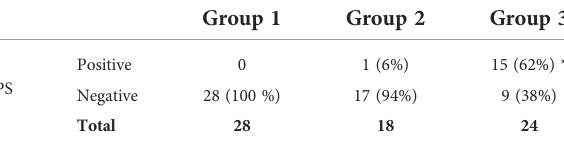
TABLE 2 Distribution of PS and STS